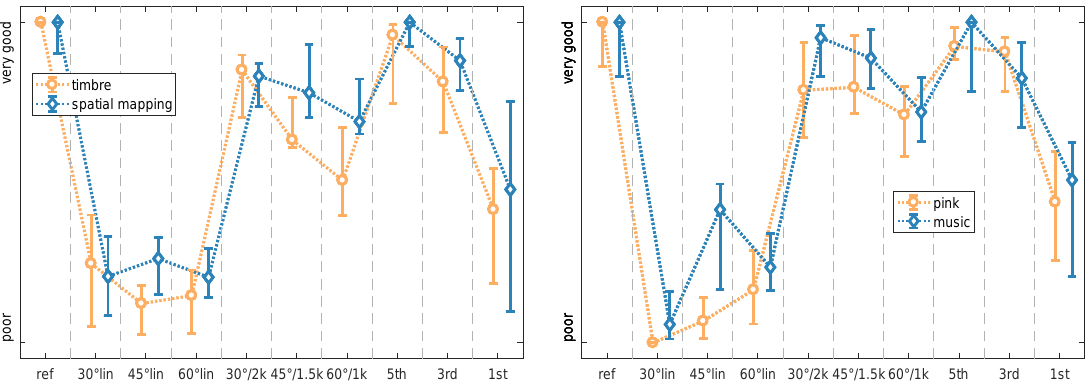
( b ) Continuity of the pooled data (virtual speaker at front and side, respectively). Figure 6. Median (markers) and 95% confidence interval (solid lines) of ratings from all nine subjects for testing the perceived difference to the reference (linearly interpolated BRIRs on a 1 ◦ resolution). Settings of the algorithm are indicated by ∆ ϕ / f c , where lin denotes a broadband linear